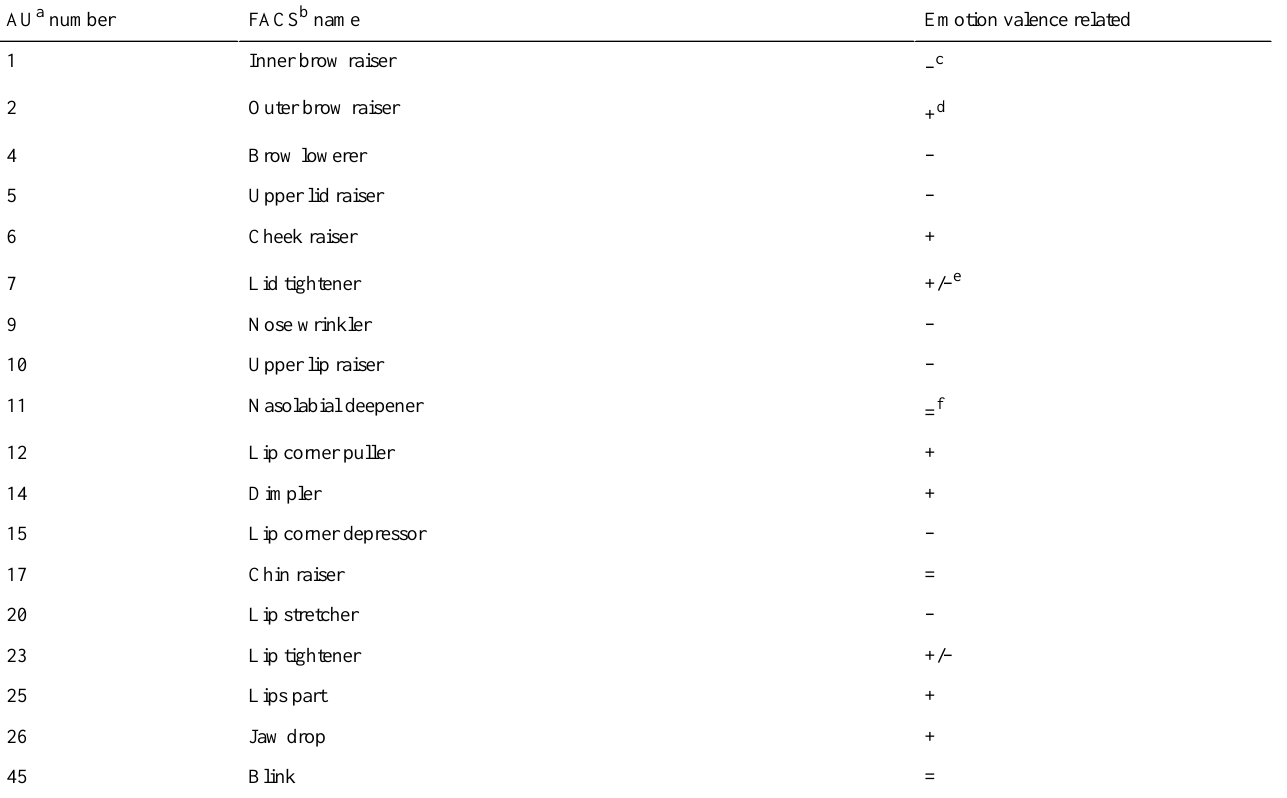
Table 1. Action unit descriptions [32] and emotion valence